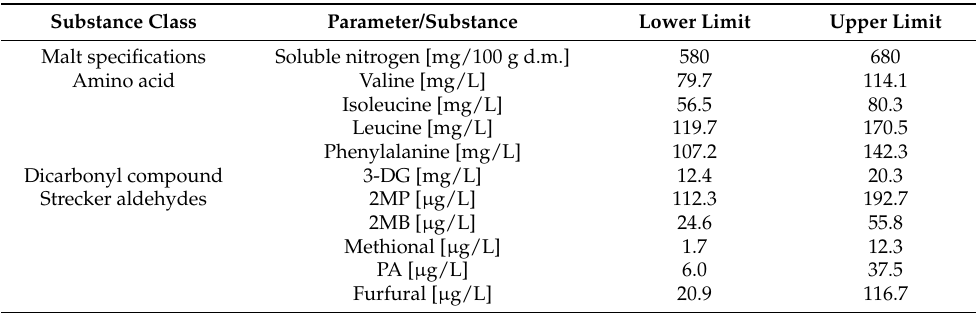
Table 5. Calculated concentration limits of selected precursors and aging aldehydes in wort according to specifications of pale